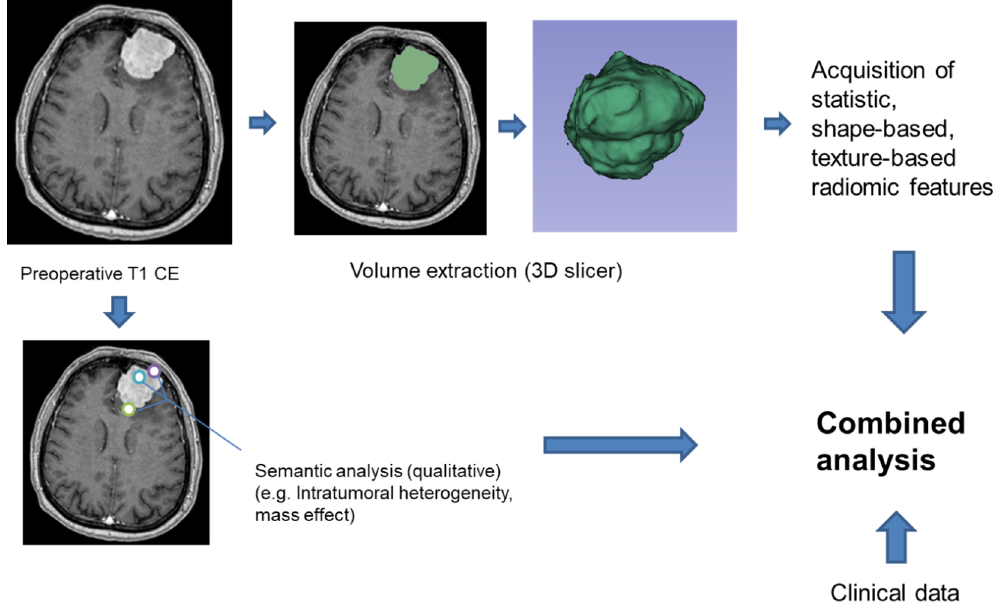
Figure 3. Workflow of the study.